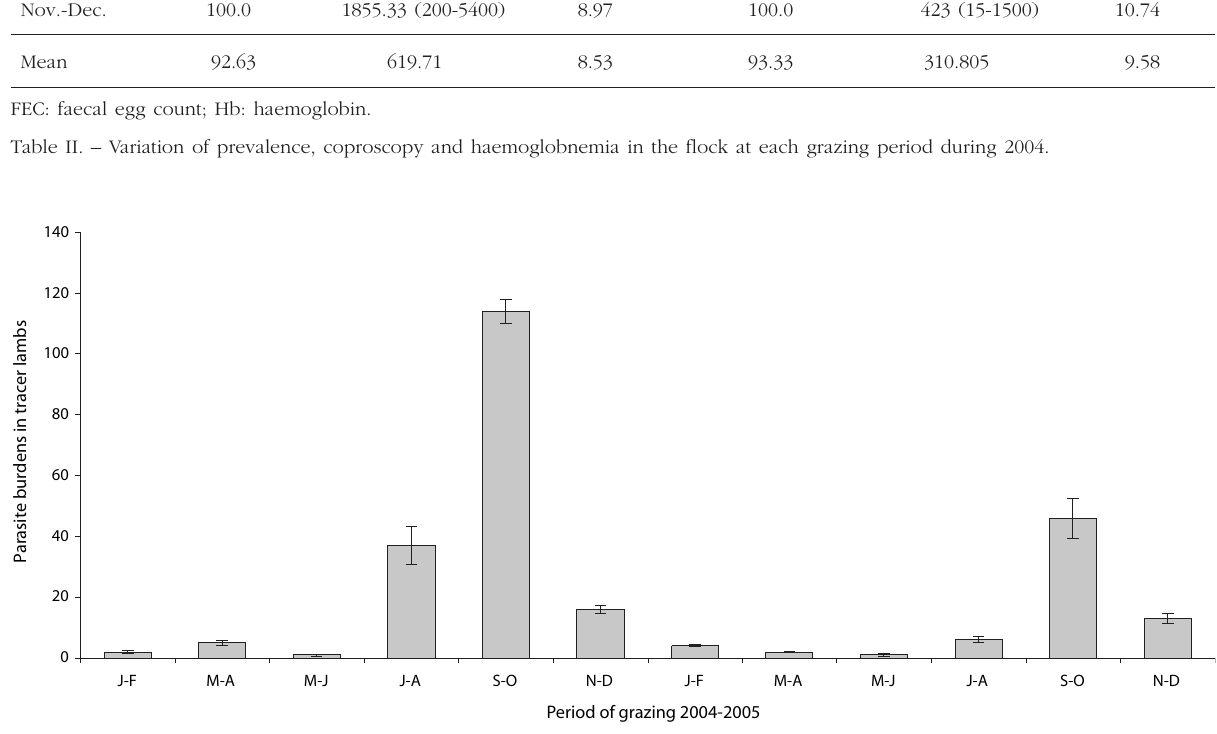
Fig. 3. – Bimonthly evolution of anoplocephalidae collected from small intestines of tracer